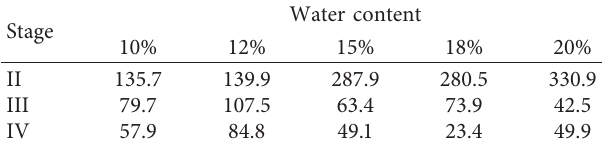
Figure 4: Variations in P-wave velocity with different water contents versus Table 2: Rate of change in P-wave velocity per degree centigrade with different water contents at different stages (m/s).